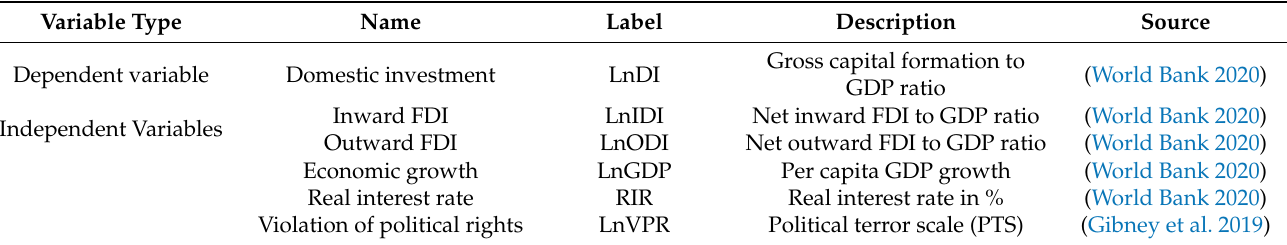
Table 2. Variable definitions and